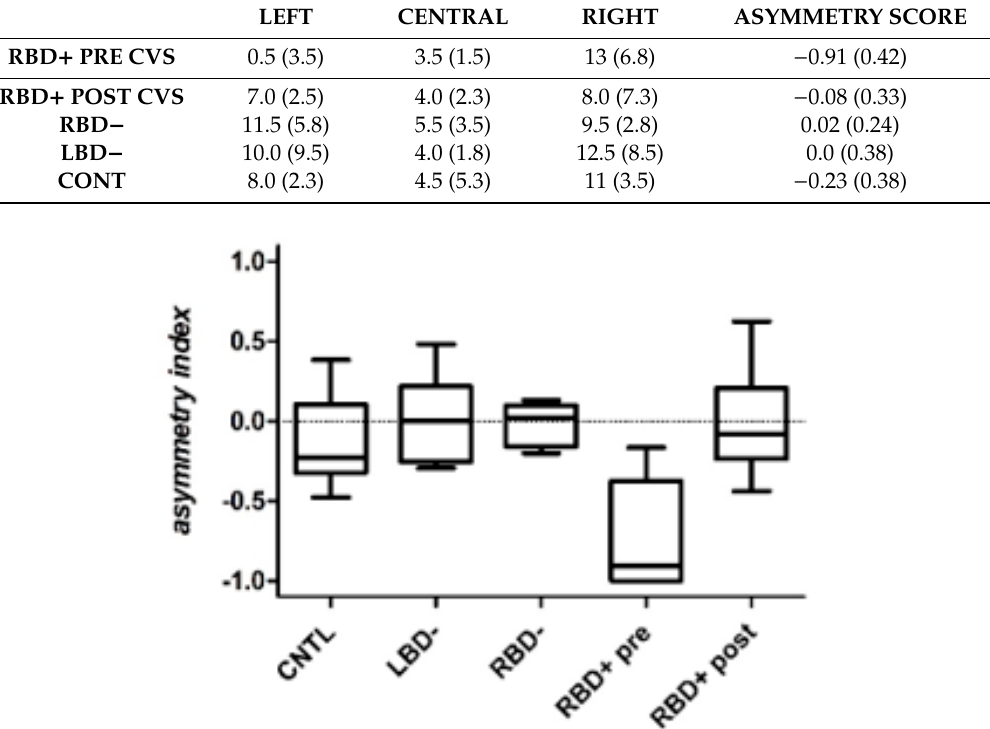
Table 3. Median (IQR) number of cities named by each group according to geographical position and asymmetry score.